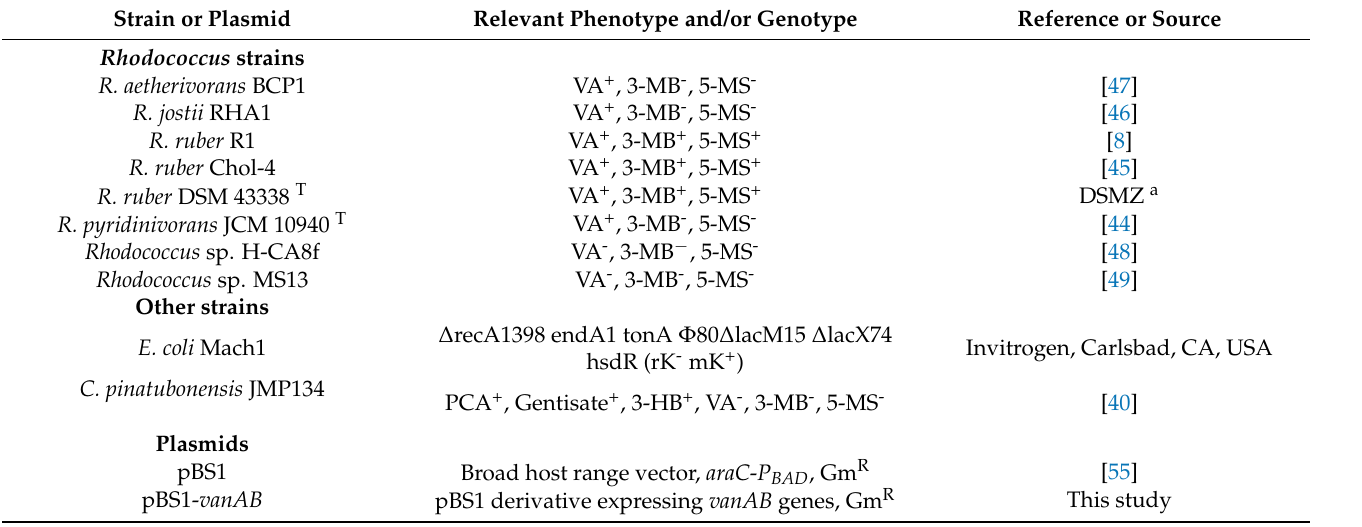
Table 1. Bacterial strains and plasmids used in this